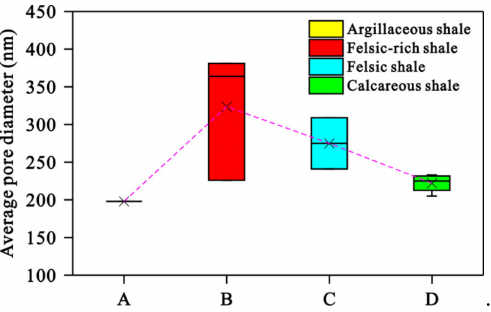
Figure 17. Average pore diameters of the four lithofacies shales.